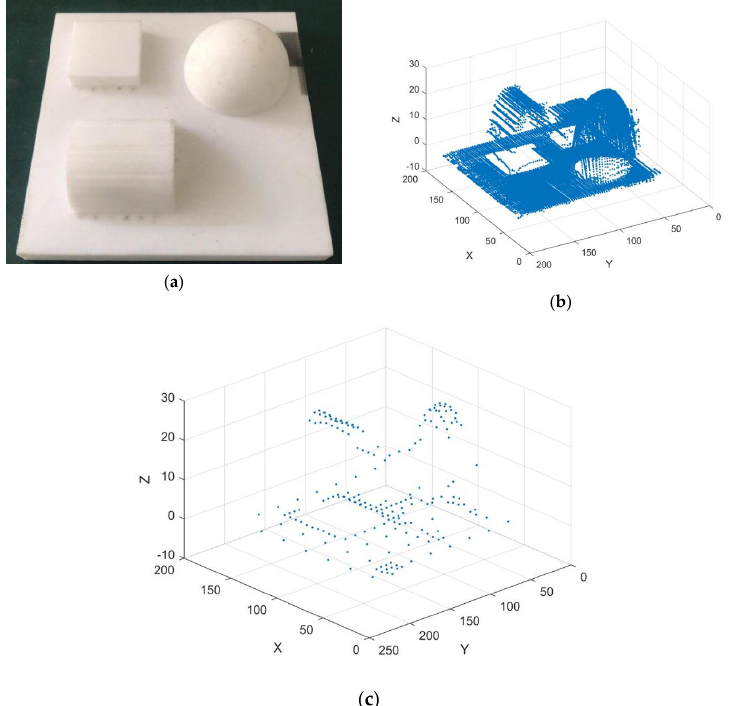
Figure 2. Effect of point cloud data preprocessing: ( a ) sample piece model, ( b ) original scan data of the sample piece, and ( c ) extracted path points